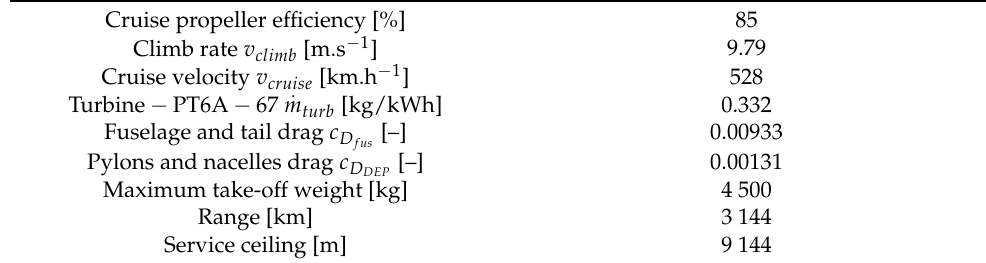
Table 4. Flight performance variable.